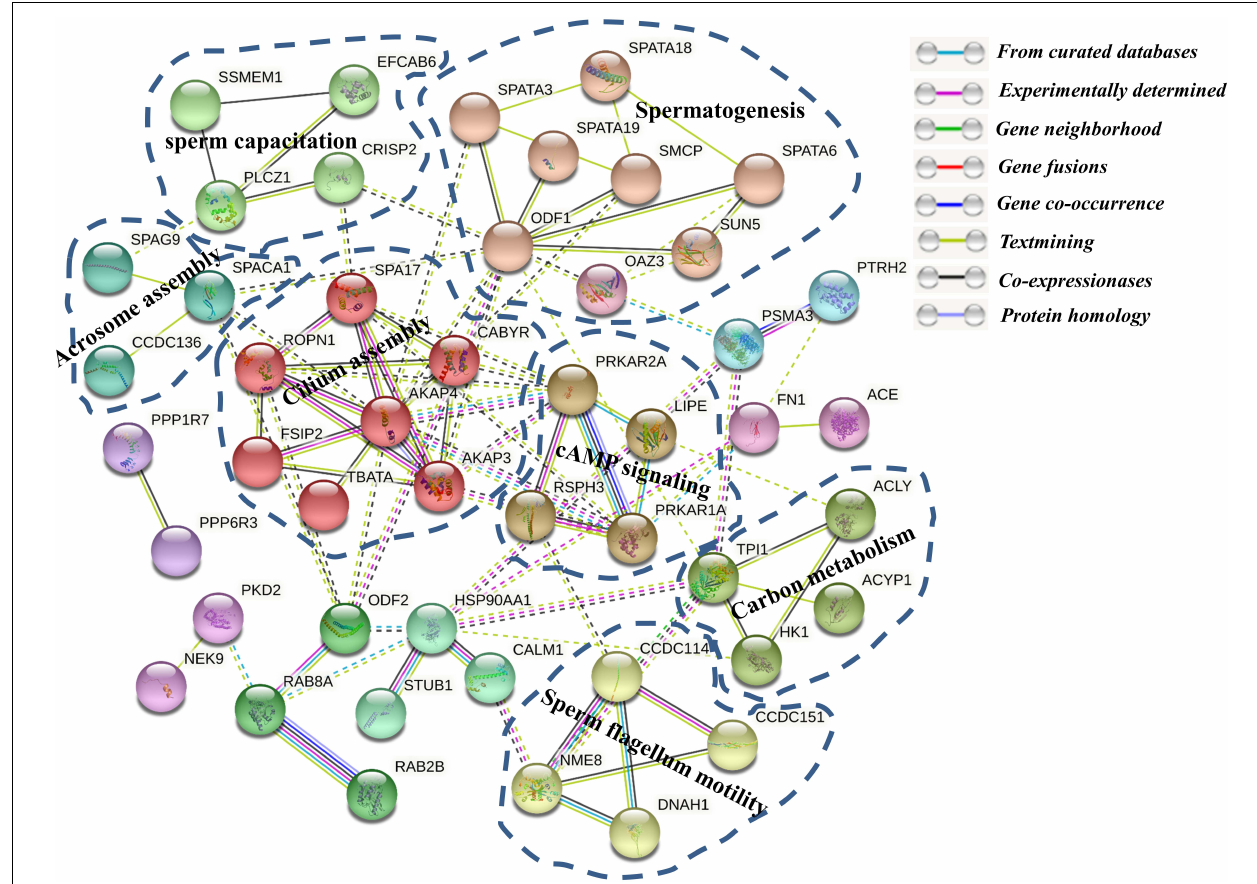
FIGURE 8 | The protein–protein interaction (PPI) network of the differentially phosphorylated phosphoproteins between Yorkshire and Duroc boar spermatozoa. The functional classification of the DPP group is shown in